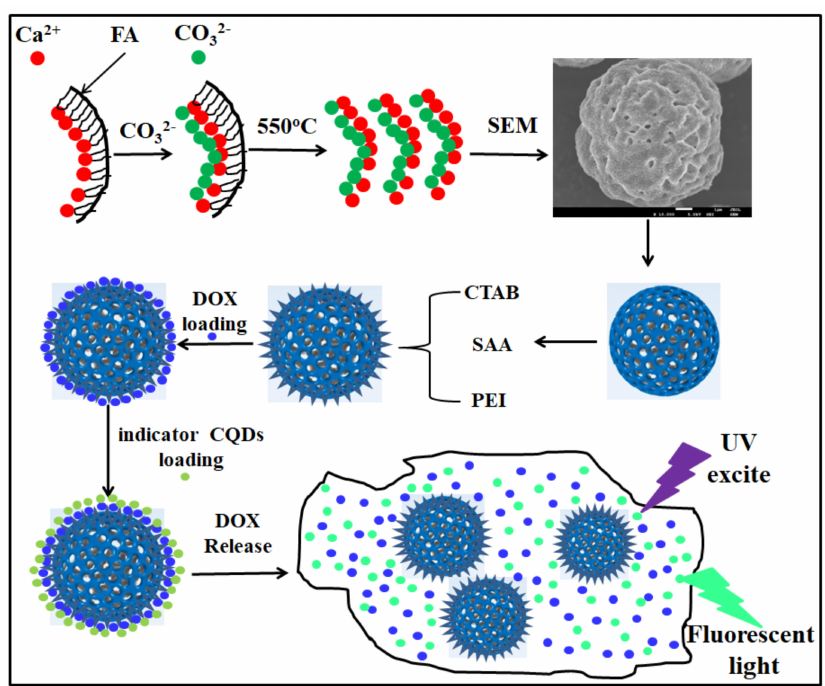
Figure 1. Schematic diagram of the preparation of FA-CaCO 3 /PEI@DOX hollow calcium carbon- ate microspheres.